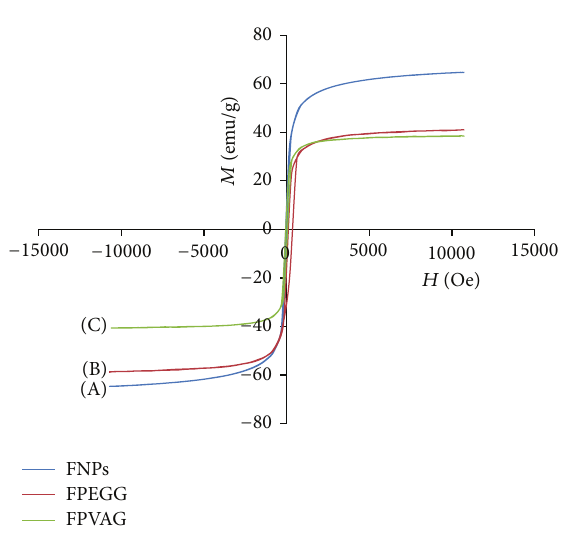
Figure 4: Magnetization plots of (A) FNPs, (B) FPEGG, and (C)